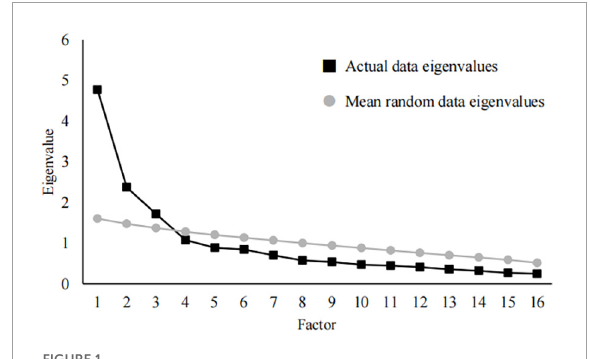
FIGURE1 Actual data eigenvalues vs. mean random data eigenvalues.